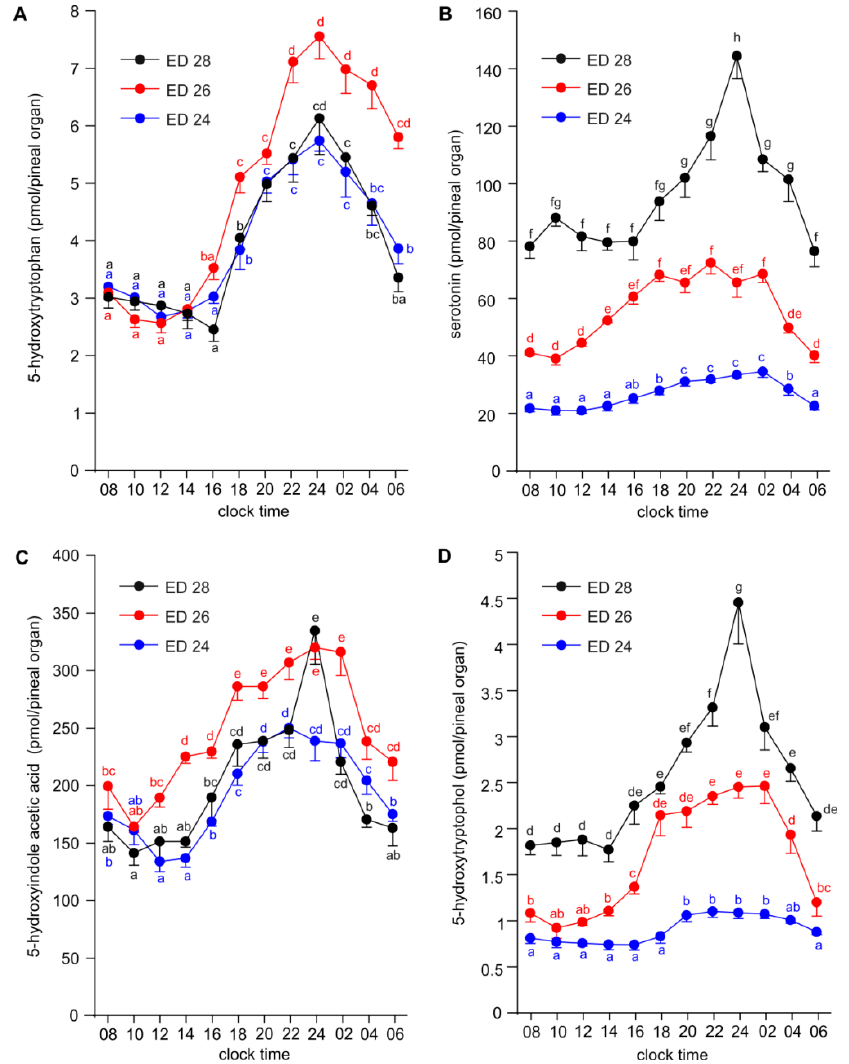
Figure 4. Diurnal changes in the content of 5-hydroxytryptophan ( A ), serotonin ( B ), 5-hydroxyindole acetic acid ( C ) and 5-hydroxytryptophol ( D ) in the pineal organs of geese embryos on ED 24, ED 26 and ED 28 (means and SEM, n = 5). Values labeled with different letters are significantly different.